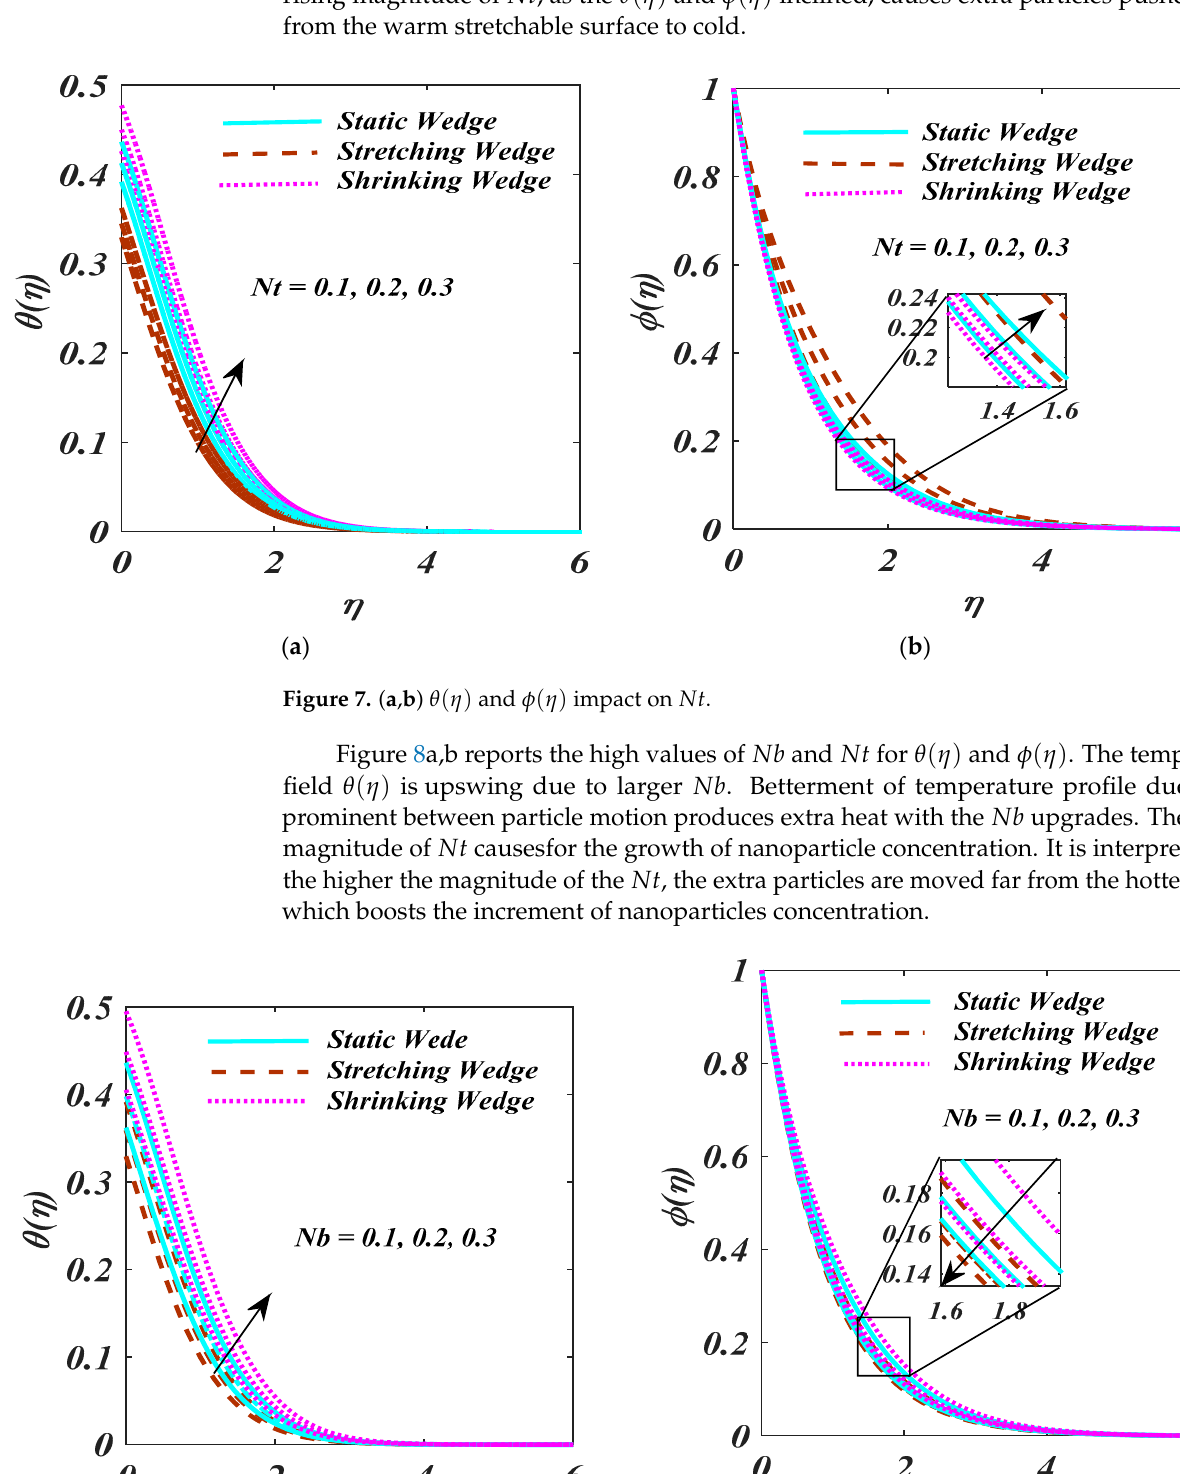
Figure 6. ( a , b ) (cid:2016)(cid:4666)(cid:2015)(cid:4667) and (cid:2038)(cid:4666)(cid:2015)(cid:4667) on (cid:1844)(cid:1856) and (cid:1845)(cid:1855) . The fluctuation in Nt is exhibited in Figure 7a,b. As the θ ( η ) and φ ( η ) enhance for the rising magnitude of Nt , as the θ ( η ) and φ ( η ) inclined, causes extra particles pushed away from the warm stretchable surface to cold.